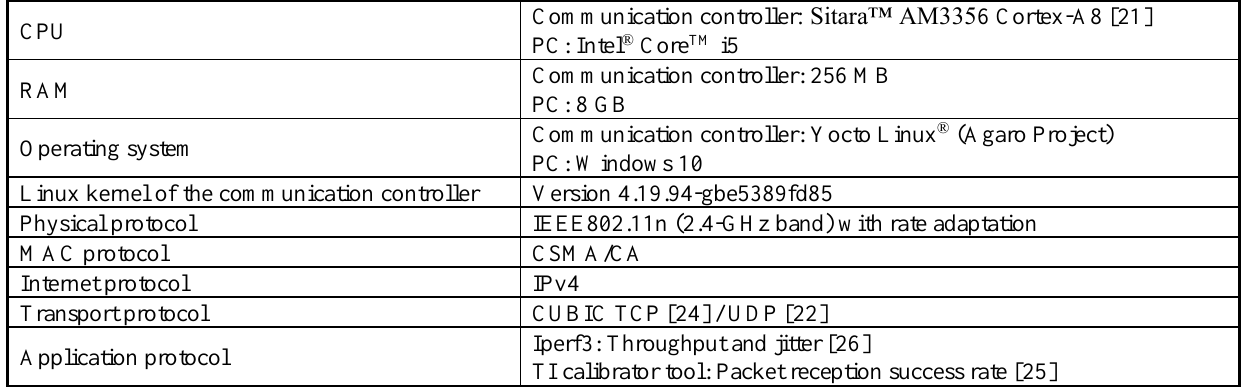
Figure 2. Test pattern 1: when the distance between the PC and the